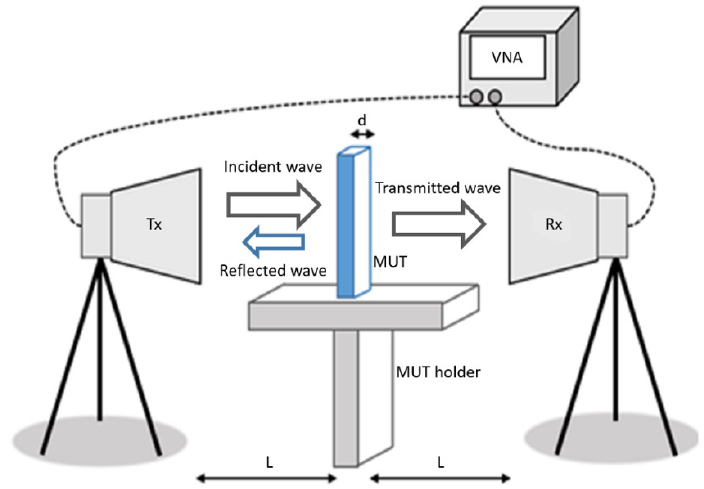
Figure 1. Illustration of the measurement setup.